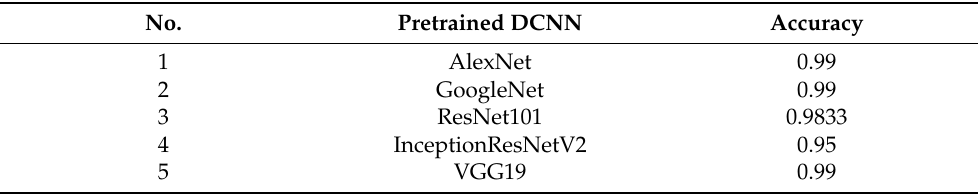
Figure 7. Classification and labelled images with the test data.